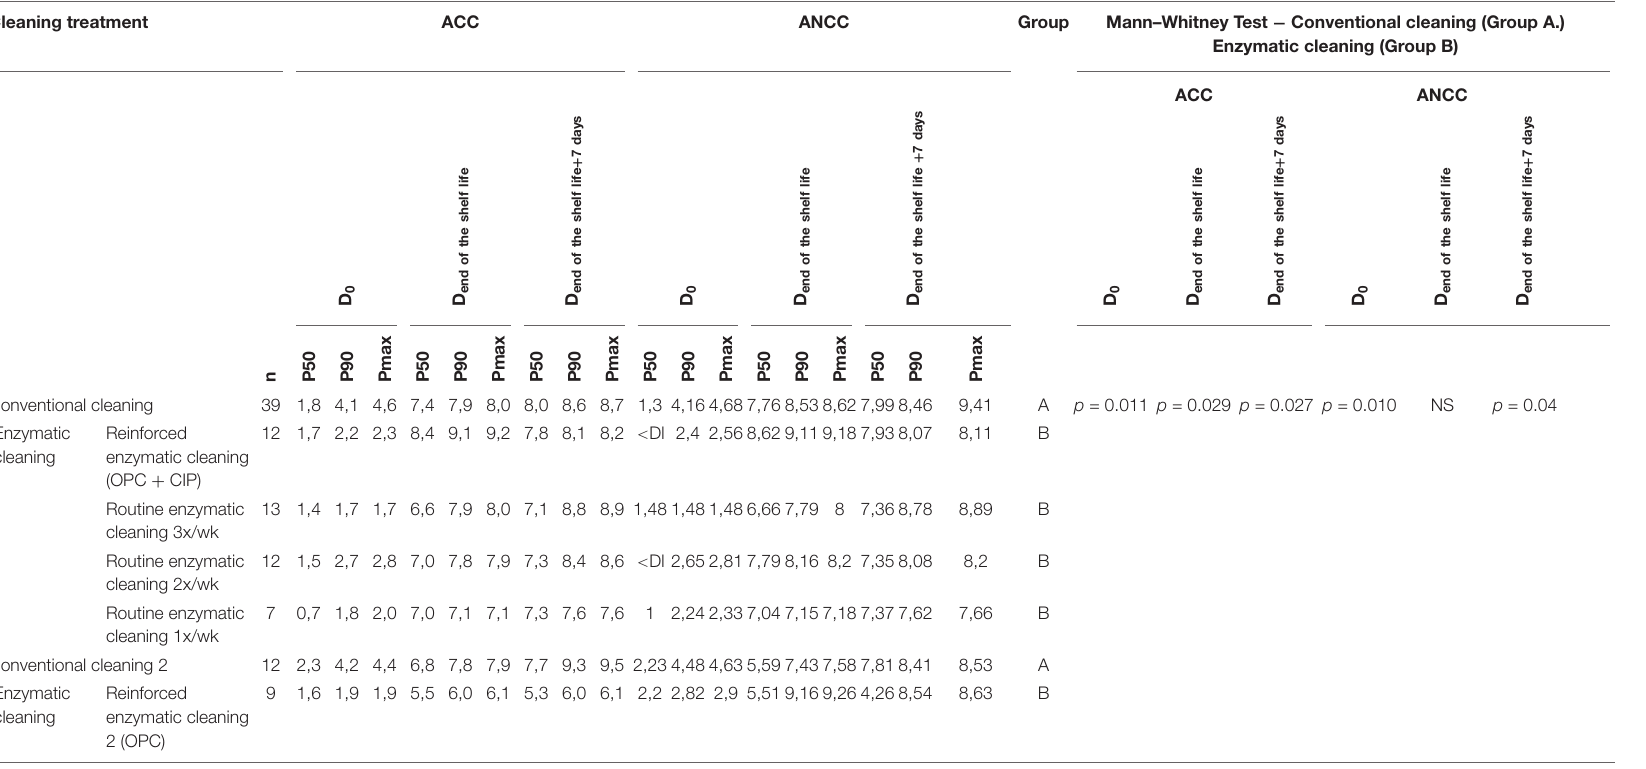
TABLE 5 | ACC and ANCC of the food product at D 0 , D end of the shelf life , and D end of the shelf life + 7 days for different cleaning treatments. Cleaning